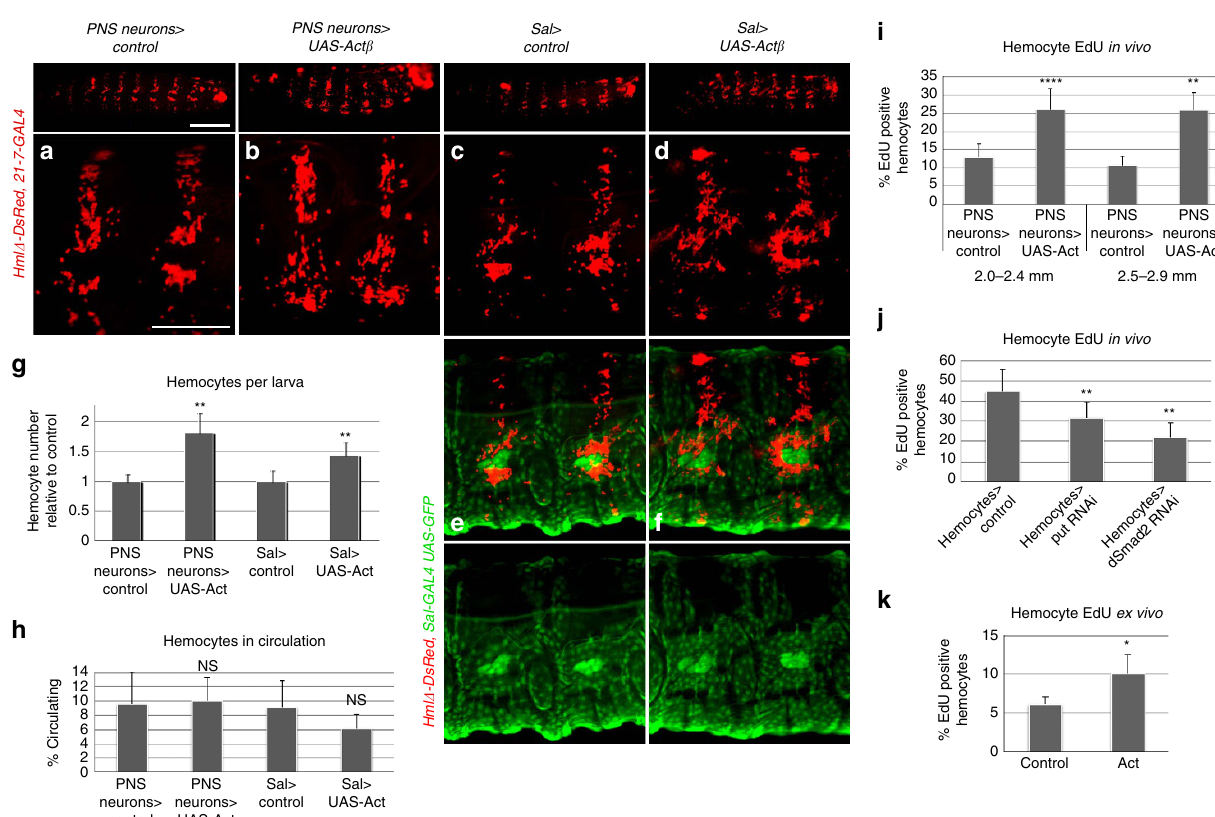
Figure 3 | Activin- b promotes hemocyte proliferation. ( a , b ) Control ( Hml D -DsRed (red), and overexpression of Act b in PNS neurons by 21-7-GAL4 with hemocytes Hml D -DsRed (red). Whole larvae lateral view (top panel), and closeup (lower panel). ( c , d ) Control and ectopic expression of Act b in ventral epidermis and oenocytes using the driver Sal-GAL4 ( GMR85E05-GAL4) marked by UAS-GFP (green), and hemocytes Hml D -DsRed (red). Whole larvae lateral view (top panel), and closeup (lower panel). ( e , f ) Same as in ( c , d ) but combined (red, green) and single channels (green) of close-up images shown. ( g ) Total hemocyte counts per larva, genotypes are 21-7-GAL4, UAS-mCD8GFP, Hml D -DsRed/ þ ; UAS-Act b / þ ( control is 21-7-GAL4, UAS-mCD8GFP, Hml D -DsRed/ þ ), n ¼ 4, seen with two different transgenes ( n ¼ 8 total); and Hml D -DsRed/ þ ; Sal-GAL4, UAS-GFP/UAS-Act b , (control is Hml D -DsRed/ þ ; Sal- GAL4, UAS-GFP/ þ ), n ¼ 5 to 6. ( h ) Hemocytes in circulation, genotypes and n as in g . ( i ) In vivo EdU incorporation, genotypes 21-7-GAL4, UAS-mCD8GFP, Hml D -DsRed/ þ (control) and 21-7-GAL4, UAS-mCD8GFP, Hml D -DsRed/ þ ; UAS-Act b (III)/ þ ; n ¼ 36 for larvae 60–70h AEL (2.0–2.4mm), and n ¼ 8 for larvae 71–83h AEL (2.5–2.9mm). ( j ) In vivo EdU incorporation, Hml D -GAL4, UAS-GFP; He-GAL4 x yw (control); x UAS-put RNAi and UAS-dSmad2 RNAi (experiment larvae); n ¼ 6; larvae 46–52h AEL (1.5–1.7mm). ( k ) EdU incorporation of released larval hemocytes stimulated with Act b ex vivo ; genotype Hml D - GAL4, UAS-GFP; He-GAL4 ; average over 4 independent experiments (Act b þ / (cid:2) conditioned media from 2 cell lines in 2 replicates each). Scale bars, a (upper panel), 0.5mm; a (lower panel), 0.2mm. Error bars represent s.d., and two-tailed t -test values correspond to NS (not significant) P 4 0.05; * P r